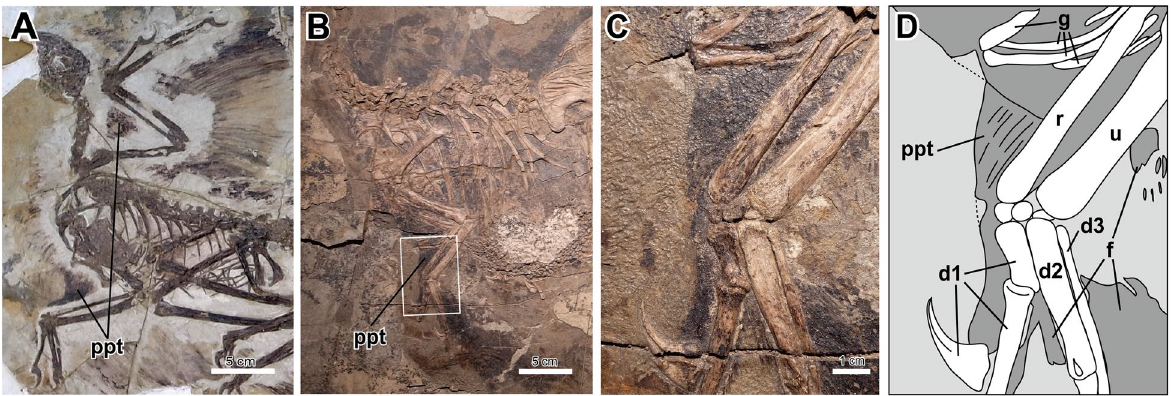
Fig. 2 Soft-tissue preservations of putative propatagia in non-avian theropods. A Microraptor gui (IVPP V 13352). B – D , Caudipteryx sp. (IVPP V 12430). C and D represent the enlarged image and line drawing of the area of the white box in B , respectively. Broken lines in D indicate missing borders of the soft tissues. d1–3, digits 1–3; f, feather; g, gastralium; ppt, propatagium; r, radius; u,